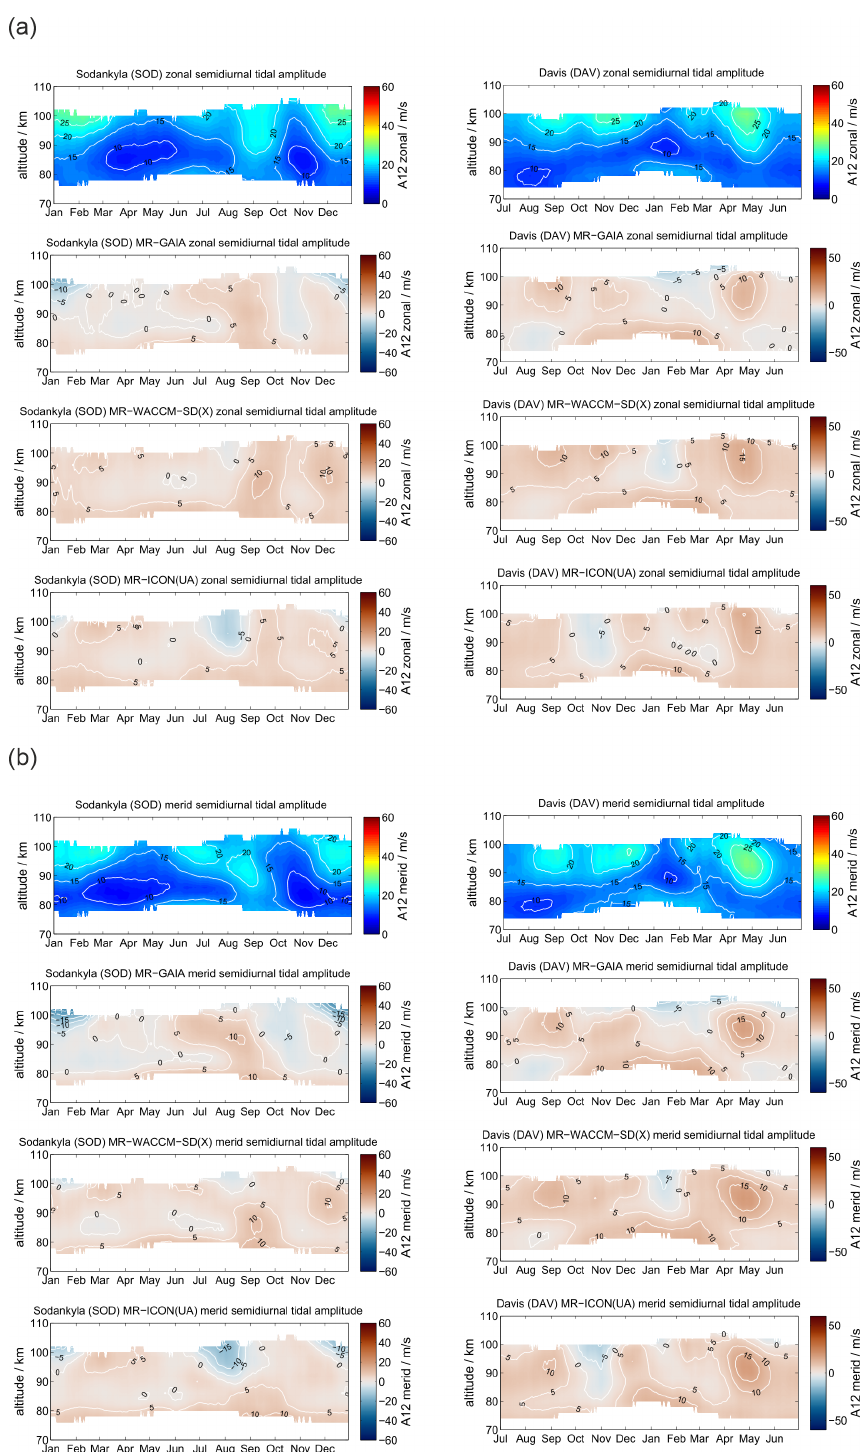
Figure D1. Absolute difference plots for semidiurnal tidal amplitudes from meteor radar and model fields for SOD and DAV.